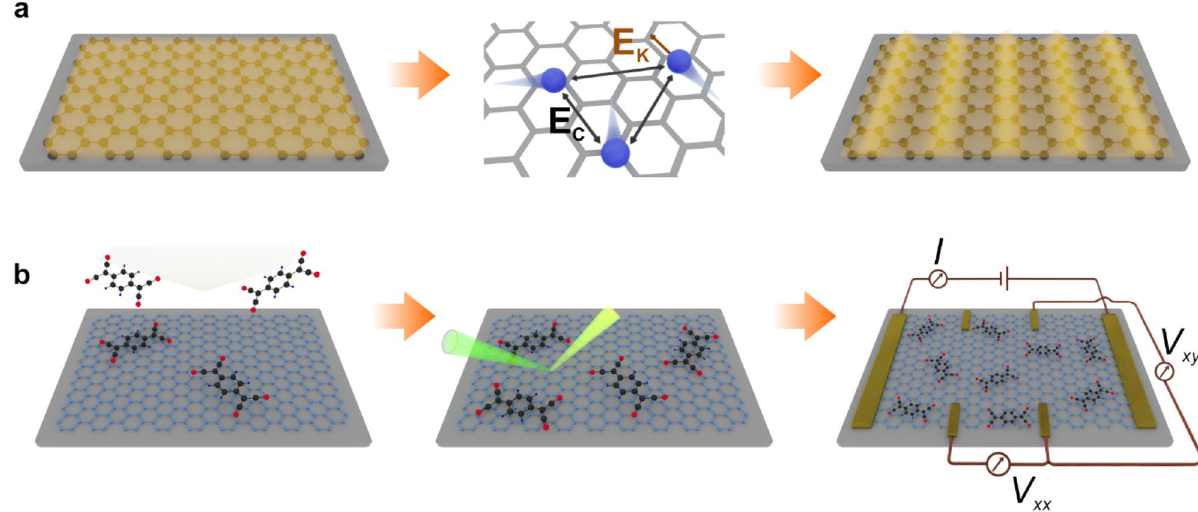
Figure 1. Schematic illustration of a generic charge ordered CDW formation & principle sample processing: ( a ) Schematic (not to scale) of a CDW formation mechanism due to generic charge ordering. Left: graphene (black lattice) with an unmodulated electron density (yellow). Middle: the magnitude of the effective mutual Coulomb interaction between charge carriers (blue spheres) relates to the ratio of their pairwise Coulomb repulsion E C (black arrows) and their kinetic energy E K (dark orange arrow) (cf. Supplementary Note 1) 46 . Right: Once E C prevails over E K , a CDW state exhibiting a periodic modulation of the charge density can principally develop. Here, for instance and for pure visualization purposes, an arbitrarily chosen one-dimensional CDW case is schematically illustrated 9,10 . ( b ) Principle workflow (not to scale) of the experimental approach. Left: Random deposition of TCNQ molecules (black: carbon, red: nitrogen, blue: hydrogen) on the graphene lattice (light blue) from the gas phase. Middle: Characterization of the samples via micro-Raman spectroscopy (incident and scattered light indicated by cones). Right: A sample electrically contacted in Hall-bar geometry and principle setup for transport measurements. For magnetotransport measurements, the magnetic field is oriented perpendicular to the sample